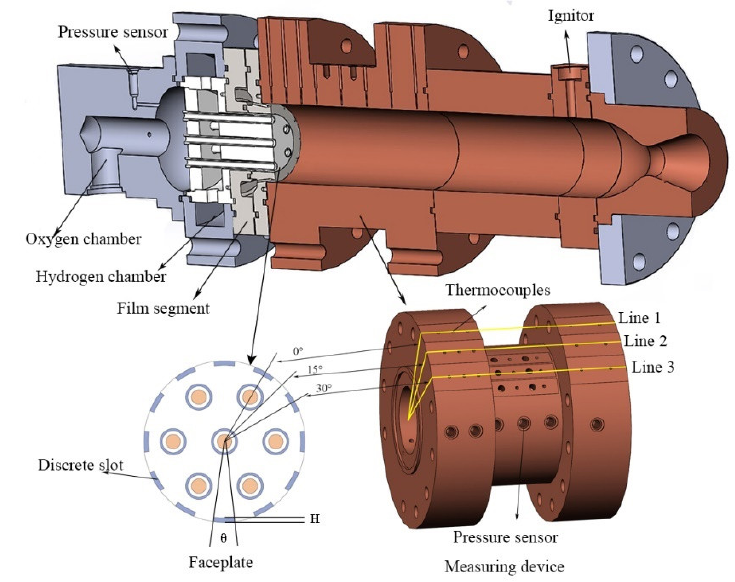
Figure 1. Configuration of the thrust chamber. Table 1. Geometry parameters of combustion chamber and injectors.